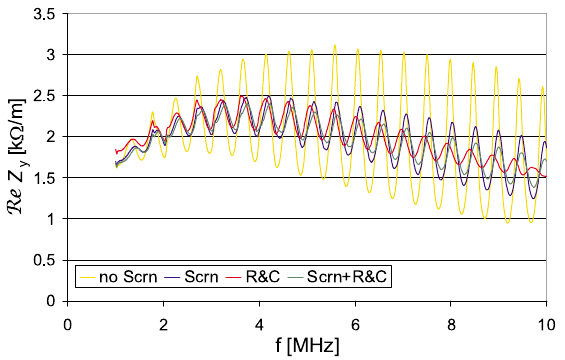
FIG. 17. (Color) Transverse impedance with modified produc- tion PFN.